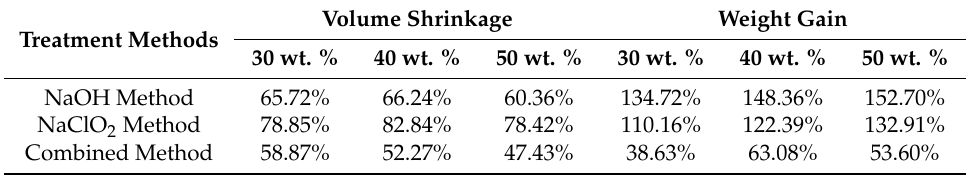
Figure 2. Morphology of the biotemplate ( a ), infiltrated aerogel template before and after solvent removal ( b , c ) and as-synthesized BioSiC ( d ). Table 1. The volume and weight changes of the BioSiC compared with templates before